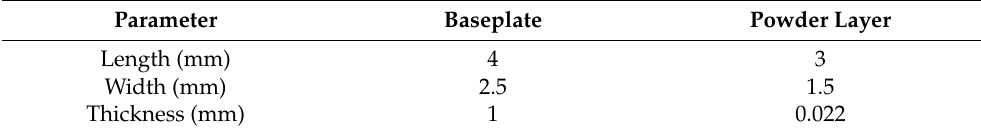
Table 1. Model dimensions.